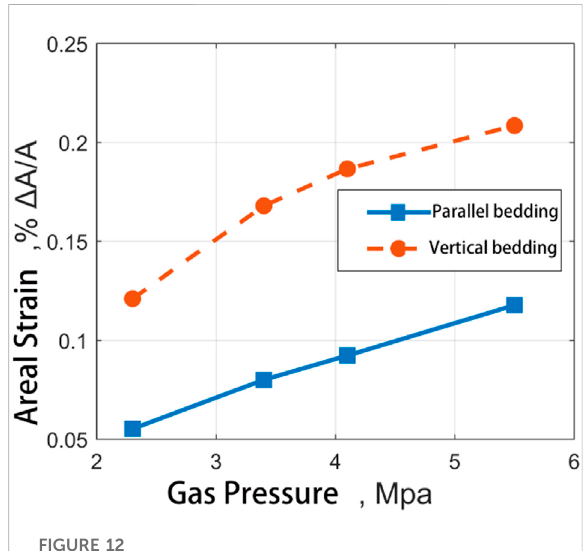
FIGURE 10 Comparison of fi tting curves of medium ash coal fi lled with CH 4 adsorption strain data with time.